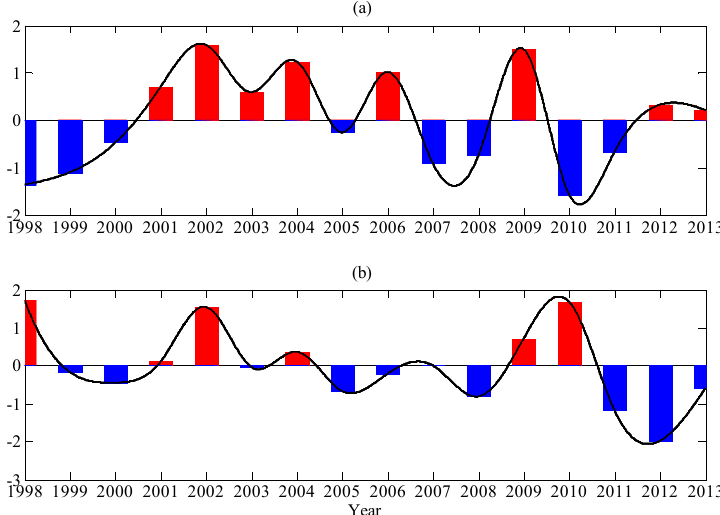
Figure 3. ( a ) Normalized PCs of the first season-reliant empirical orthogonal function (SEOF) mode for precipitation in the Pacific Ocean from summer 1998 to spring 2014; ( b ) as in ( a ), but for the second mode.